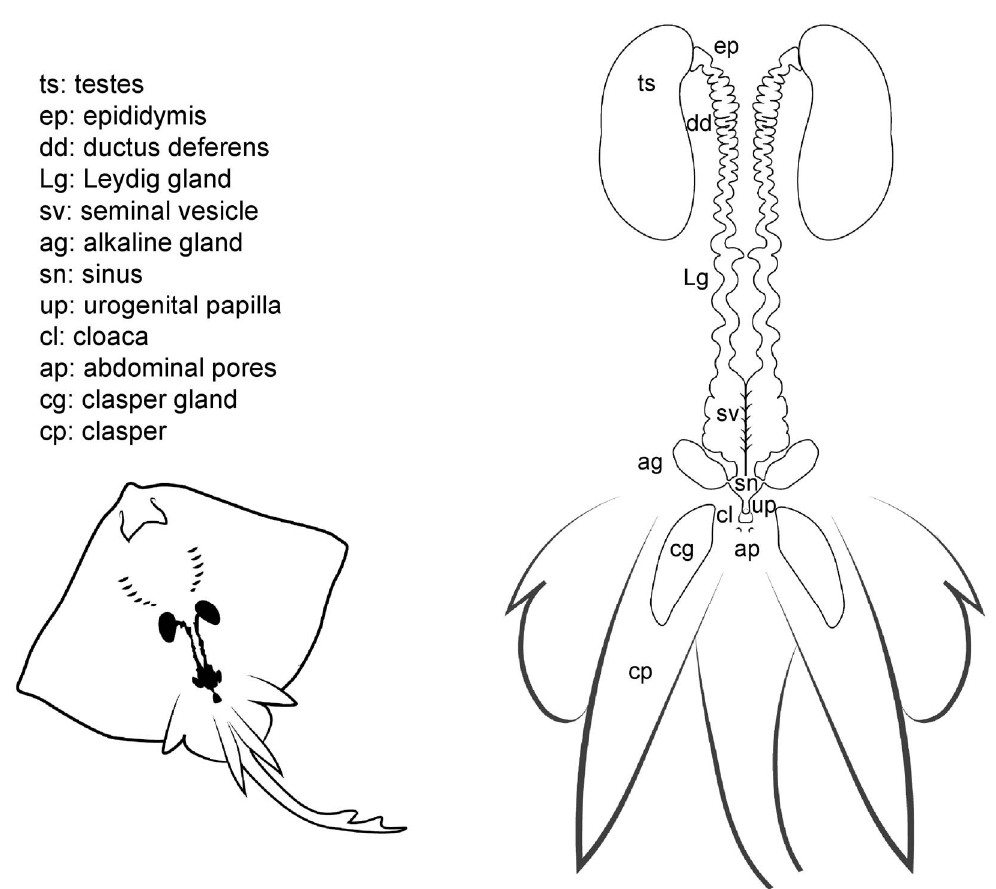
Figure 5. Male general anatomy. Morphological scheme of an ideal batoid male, showing the main reproductive structures: testes, epididymis, ductus deferens, Leydig seminal vesicles, alkaline glands, sinus, urogenital papilla, cloaca, abdominal pores and clasper glands.